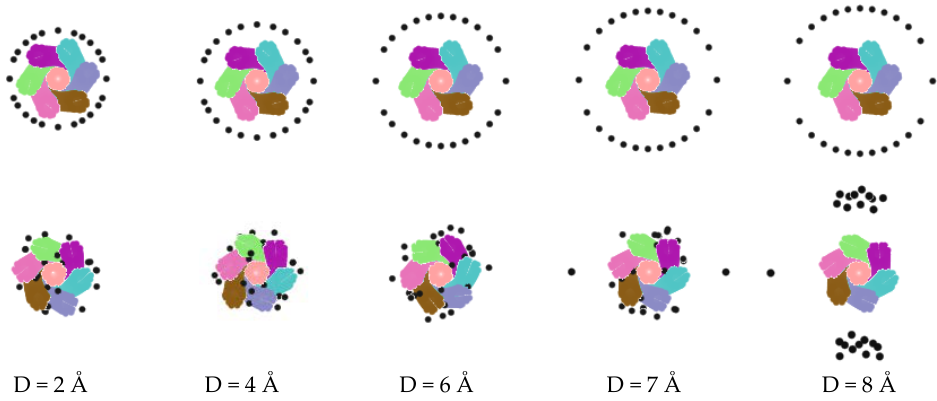
Figure 4. Relation between distance and adsorption.